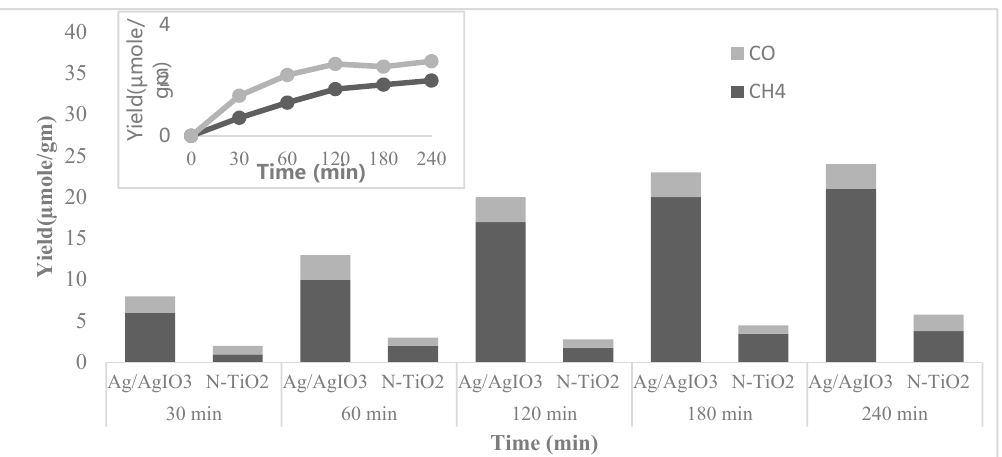
Figure 6. Schematic diagram showing time dependence yields of CH 4 and CO yields under visible light irradiation over Ag/AgIO 3 particles and over N doped-TiO 2 . The inset shows the time dependence of CH 4 and CO yields over AgIO 3 under UV-vis light (Reproduced from [57]).